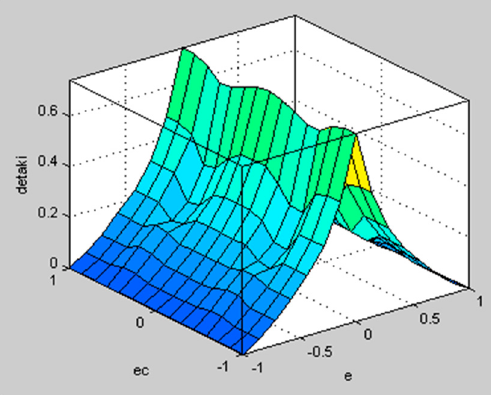
Figure 10. Fuzzy surface of ∆ k I